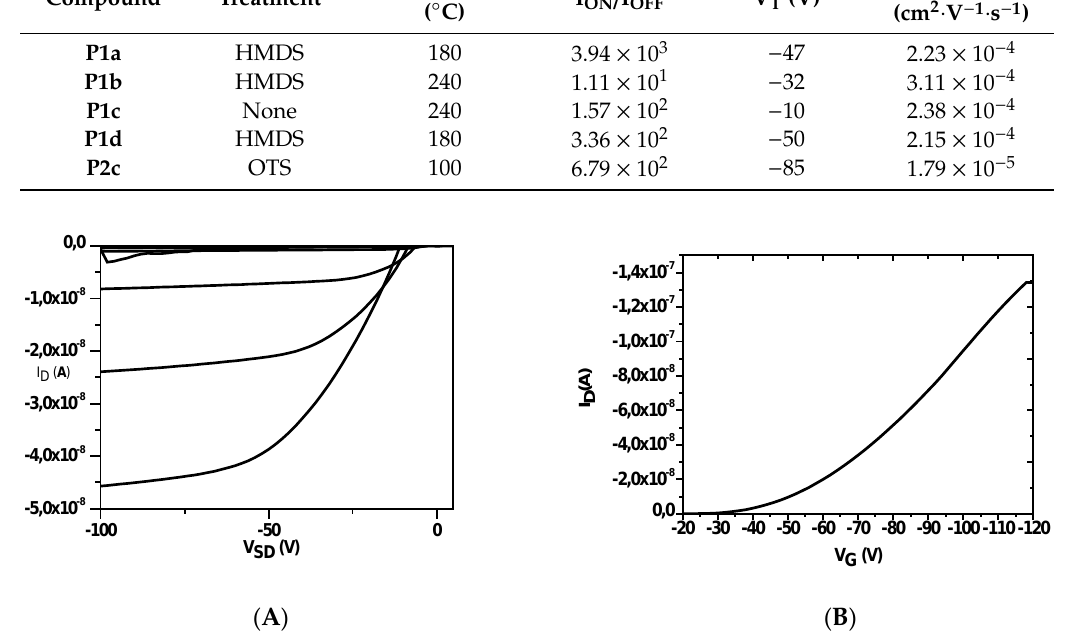
Table 4. Summary of the organic field-e ff ect transistors (OFET) parameters for the studied polymers. Compound